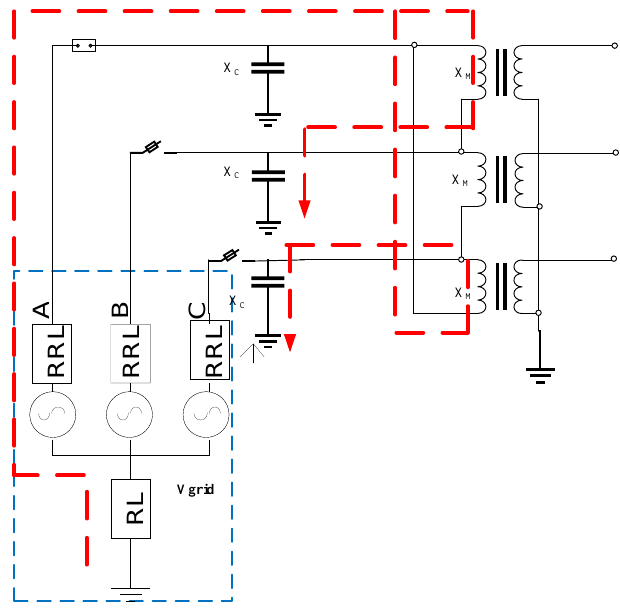
Figure 10. The series LC ferroresonance circuit for Case I. Table 1. The parameters for simulation Case I.